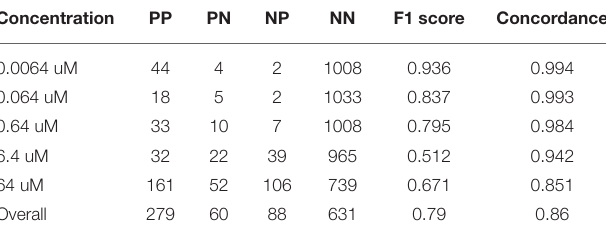
FIGURE 3 | Sensitivity analysis of behavioral endpoints. Each point on the plot represents the sensitivity and specificity of these assays when using a combination of parameters described in section Sensitivity Analysis of Behavioral Responses of Methods to call hits using behavior and morphology (Parameters include the number of endpoints used to make “affected” calls in morphology, p -value threshold for Fisher’s exact test, percent change thresholds for hypo and hyper-activity).